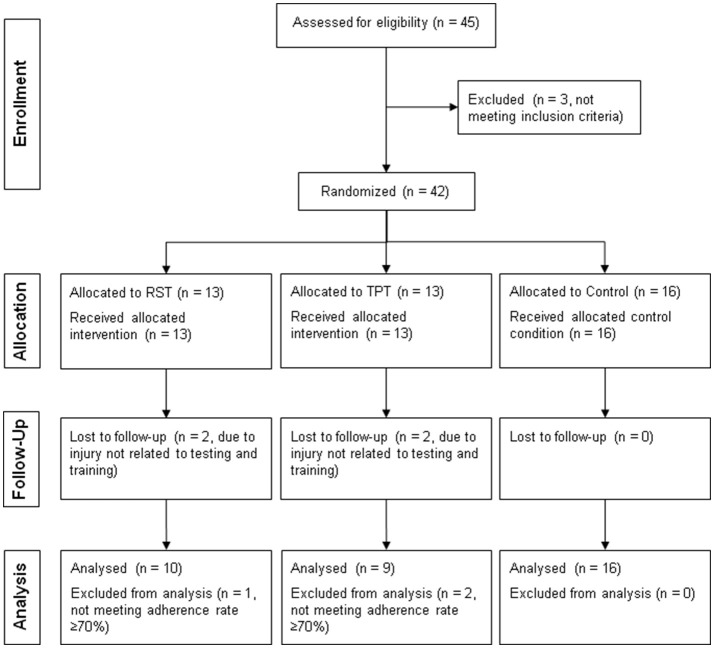
Flowchart of the study design.